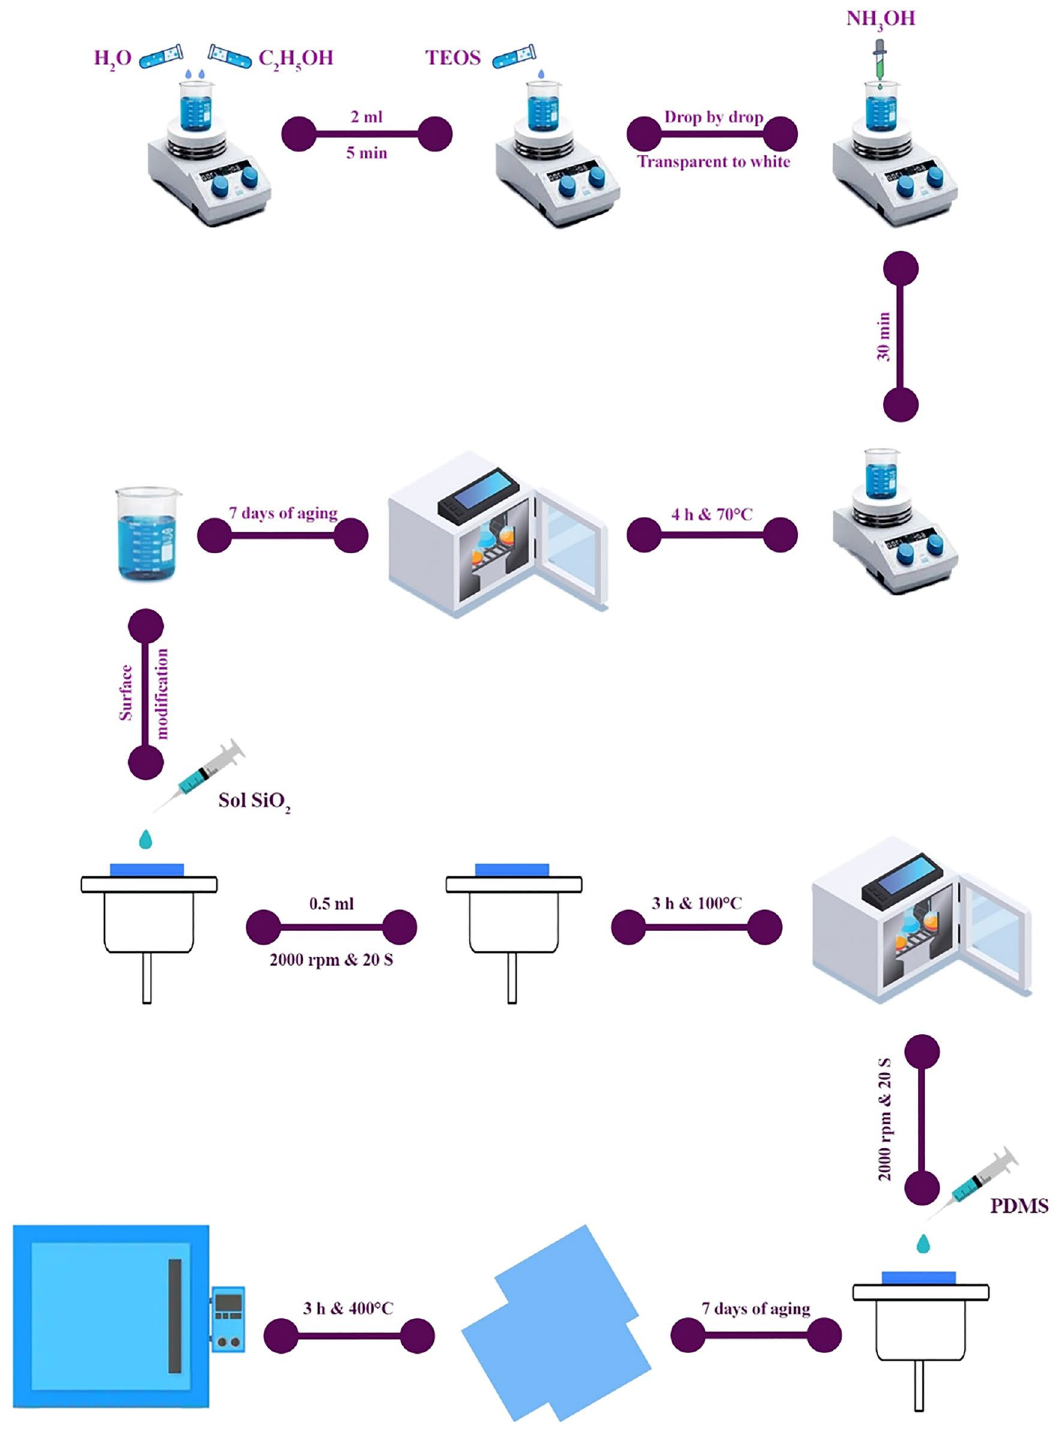
Figure 1. Superhydrophobic coating synthesis